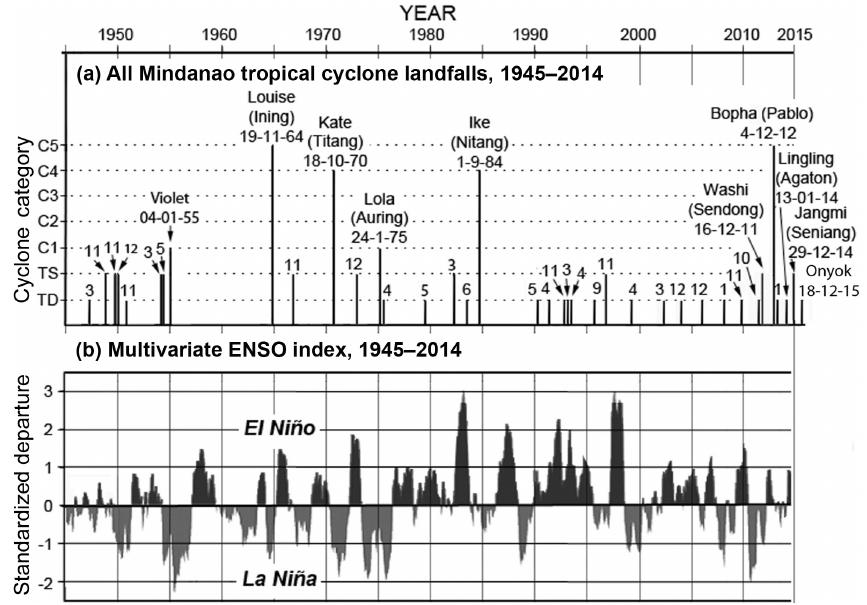
Figure 6. (a) From Unisys (2012), JTWC (2012, 2013) and NASA (21 January–30 December 2015). TD = Tropical Depression; TS = Tropical Storm. Typhoons fully dated; TDs and TSs dated by month number only (January = 1 to December = 12). Panel (b) modified from NOAA Earth Science Research Laboratory